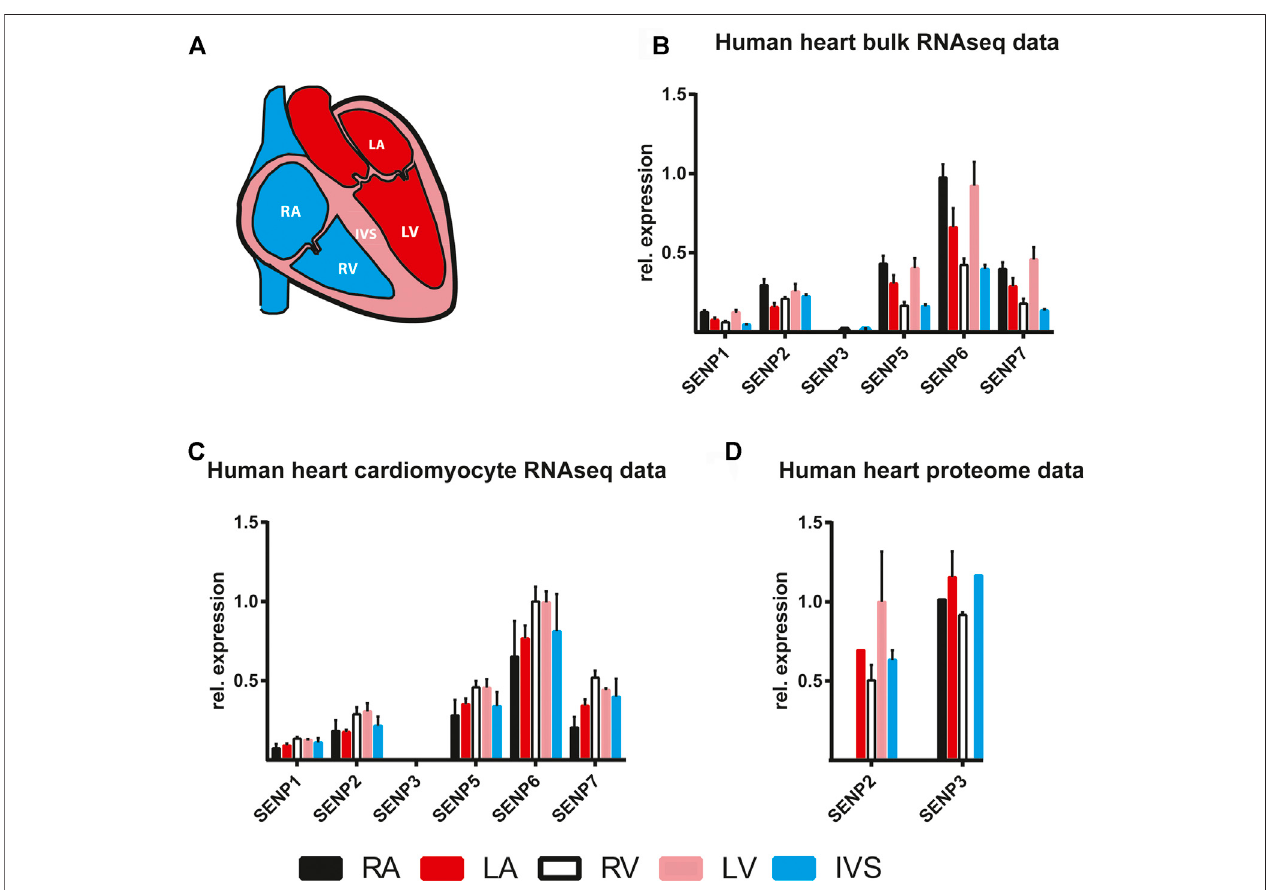
FIGURE2| RNAandproteinexpression ofSENPsindifferentanatomicalareasofthehumanheart (A) Graphicalillustrationoftheanatomicalregionsofthehuman heart (B,C) Non-failinghumanheartsamples,declinedfortransplantationwereusedforeitherbulkRNAisolationandsequencing(B,(Johnsonetal.,2018),orforsingle cell RNA analysis (C (Litvi ň uková et al., 2020)). By normalizing the original SENP expression data to those of the cardiac housekeeping gene GAPDH in both studies, region-speci fi cSENPexpressioninthehumanhearthasbeenre-analyzedandcompared (D) SENPproteinexpressioninhumanheartregions(Dolletal.,2017).N (cid:1) one to three, mean ± SD are shown. RA: Right atrium, LA: Left atrium, RV: right ventricle, LV: left ventricle, IVS: interventricular